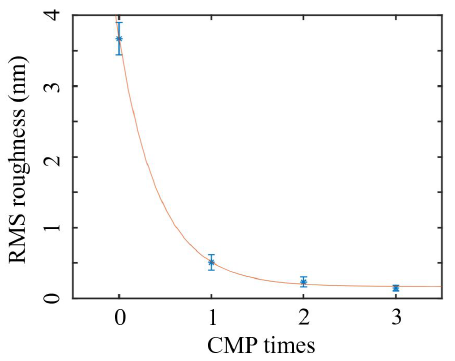
Figure 2. AFM images with 1 µm × 1 µm measurement fields of the 4H-SiC chip surface with ( a ) twice and ( b ) thrice wet-oxidation-assisted CMP processes, and ( c ) post oxidation after the third CMP.